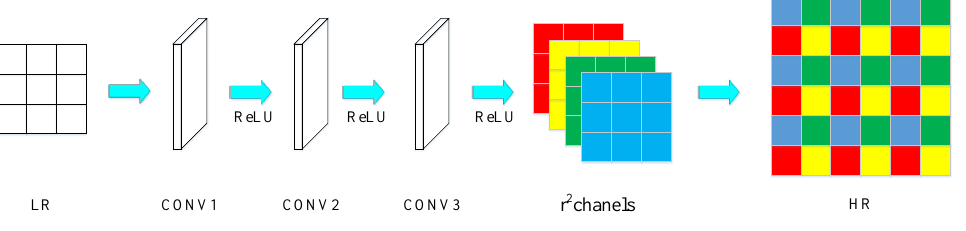
Figure 7. The sub-pixel up-sampling